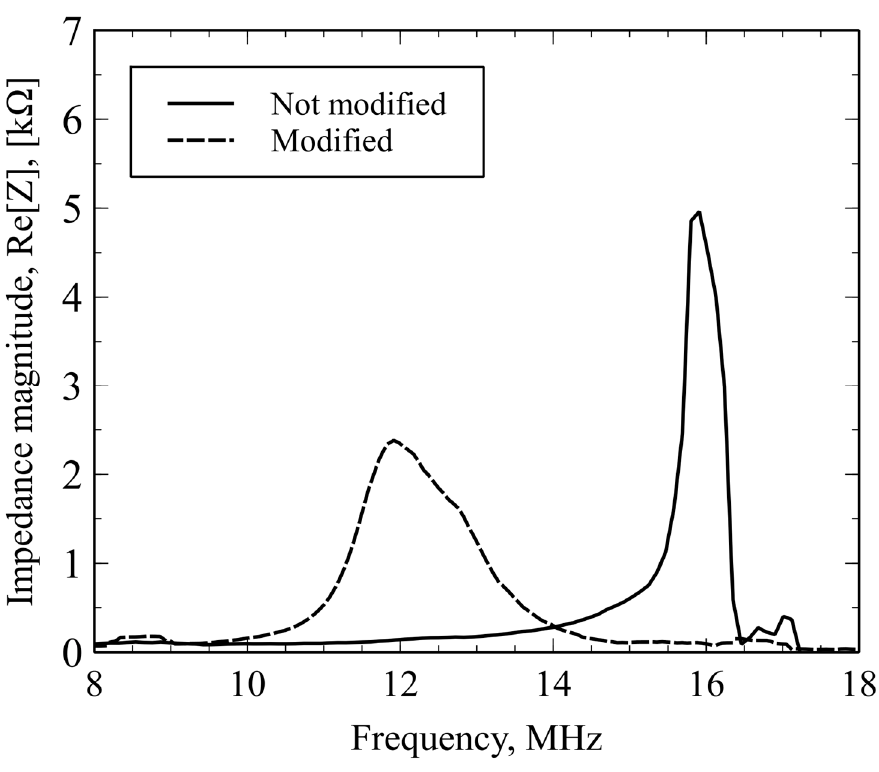
Figure 4. Impedance magnitude spectra of the CMUT device before and after spin-coated methylated poly(ethylene-imine) (mPEI) layer as a function of frequency.